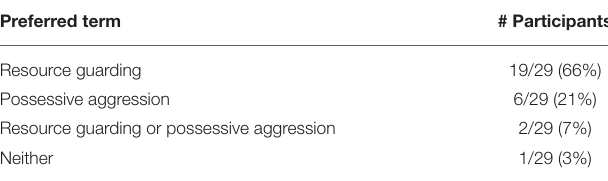
TABLE 2 | Count of terminology preference from participants in survey stage